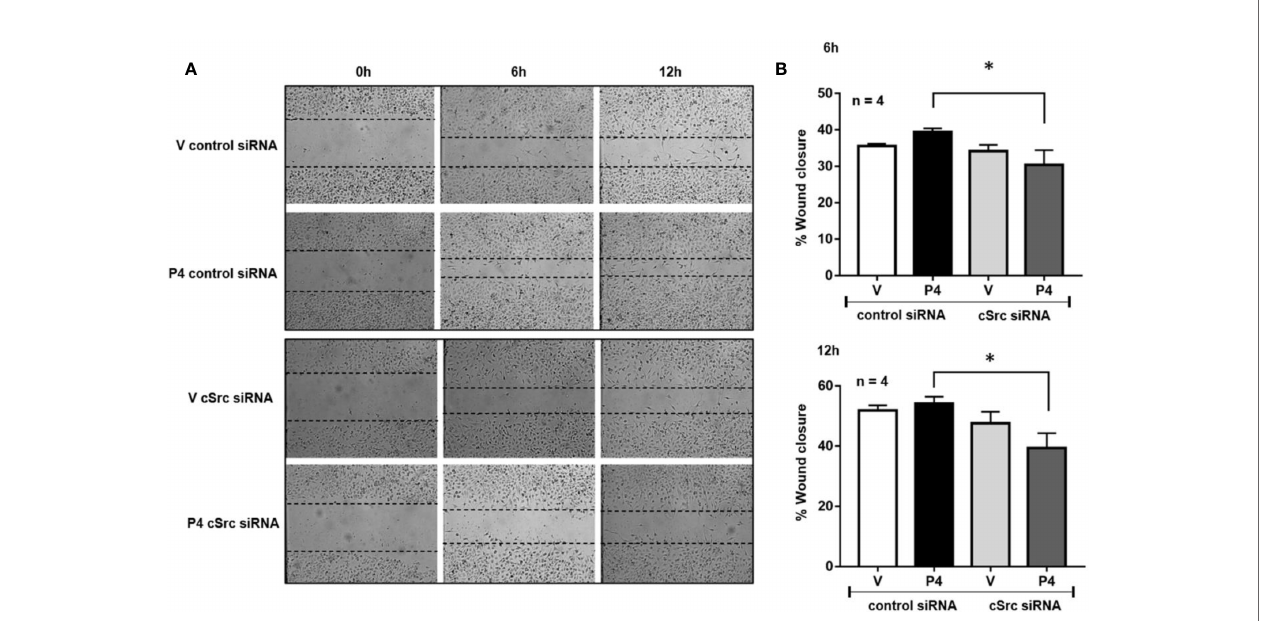
FIGURE 3 | cSrc participates in cell migration induced by P4. U251 cells transfected with cSrc siRNA and a control siRNA (an aleatory RNA sequence) (100 nM) were treated with P4 (50 nM) or vehicle (V, DMSO 0.01%) in cells. Photographs from the scratch area were taken at 0, 6 and 12 h and were captured with 400× magni fi cation. (A) Representative image of the scratch area. (B) Graph of the wound closure (%), determined in the scratch area. Results are expressed as the mean ± S.E.M. n = 4; *p <